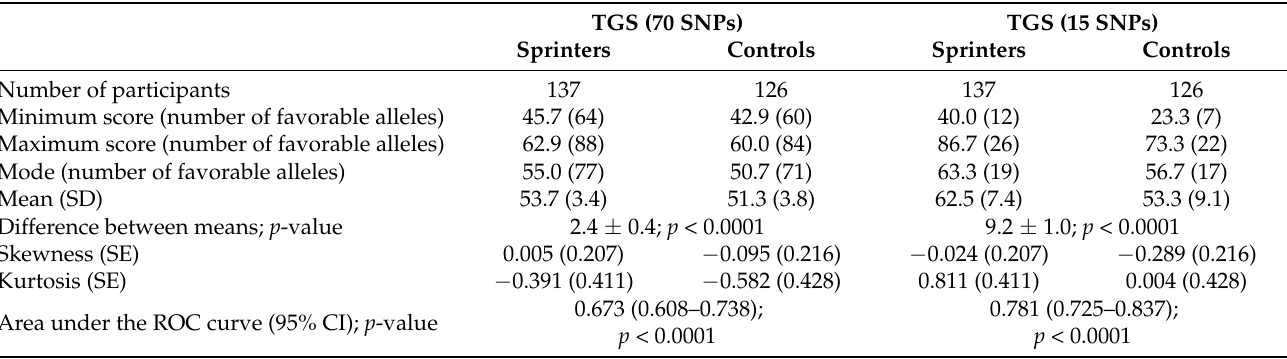
Table 3. The total genotype score (TGS) computed using all 70 SNPs related to self-reported walking pace or only the 15 SNPs associated with brisk walking and sprinter